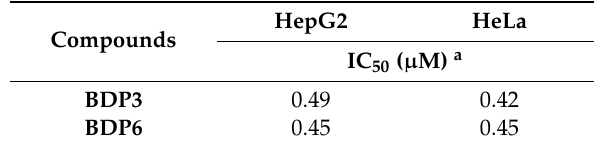
Table 2. IC 50 values of BDP3 and BDP6 against HepG2 and HeLa cells.